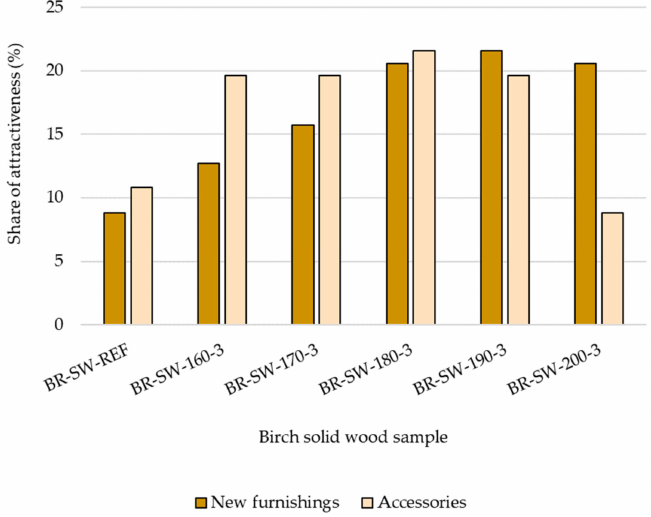
Figure 13. The preference in the samples in the case of purchasing accessories and new furnishing—solid birch wood. BR-SW-REF = untreated birch solid wood; BR-SW-160-3 = birch solid wood treated at 160 ◦ C / 3 h; BR-SW-170-3 = birch solid wood treated at 170 ◦ C / 3 h; BR-SW-180-3 = birch solid wood treated at 180 ◦ C / 3 h; BR-SW-190-3 = birch solid wood treated at 190 ◦ C / 3 h; BR-SW-200-3 = birch solid wood treated at 200 ◦ C / 3